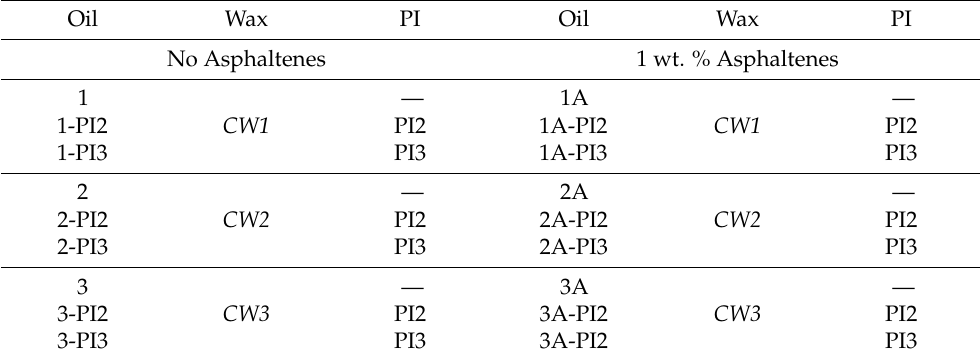
Table 3. Synthetic oil samples, each containing 10 wt. %